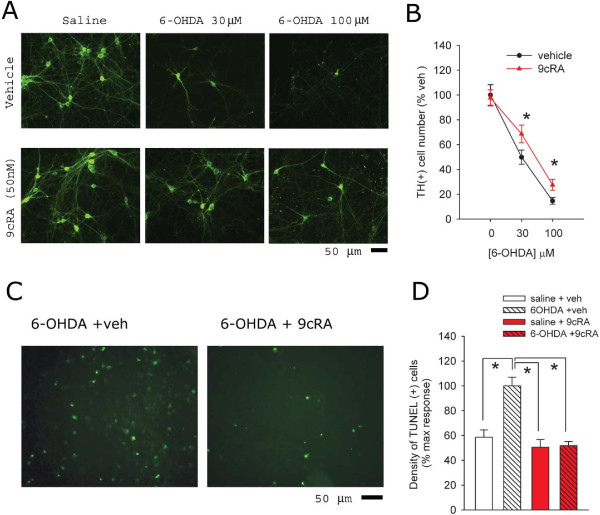
9cRA reduces 6-OHDA-induced toxicity in ventral mesencephalic cultures. (A) Primary cultures prepared from rat VM (E15) were treated with 6-OHDA (0, 30, 100 μM) for two hours then washed and exposed to vehicle or 9cRA for 22 hours. Cells were fixed and assayed using TH immunostaining. 9cRA (50 nM) alone did not alter the TH (+) neurons in culture; however, it antagonized the 6-OHDA-mediated decrease in TH cell density. (B) A dose-dependent effect of 6-OHDA on loss of TH cells. Treatment with 9cRA (50 nM) significantly antagonized the loss TH cells induced by 6-OHDA (*p<0.05, 2- way ANOVA). The density of TH (+) cells was normalized to the cell density in the non-6-OHDA and non-9cRA (vehicle) -treated group. (C) 9cRA reduced 6-OHDA (100 μM) –mediated TUNEL labeling in VM neuronal culture. (D) Averaged TUNEL density per field. All data were normalized to the mean of TUNEL density in 6-OHDA +veh group. Treatment with 9cRA (50 nM) significantly reduced 6-OHDA- mediated TUNEL activity to control levels (*p<0.001, 1- way ANOVA).